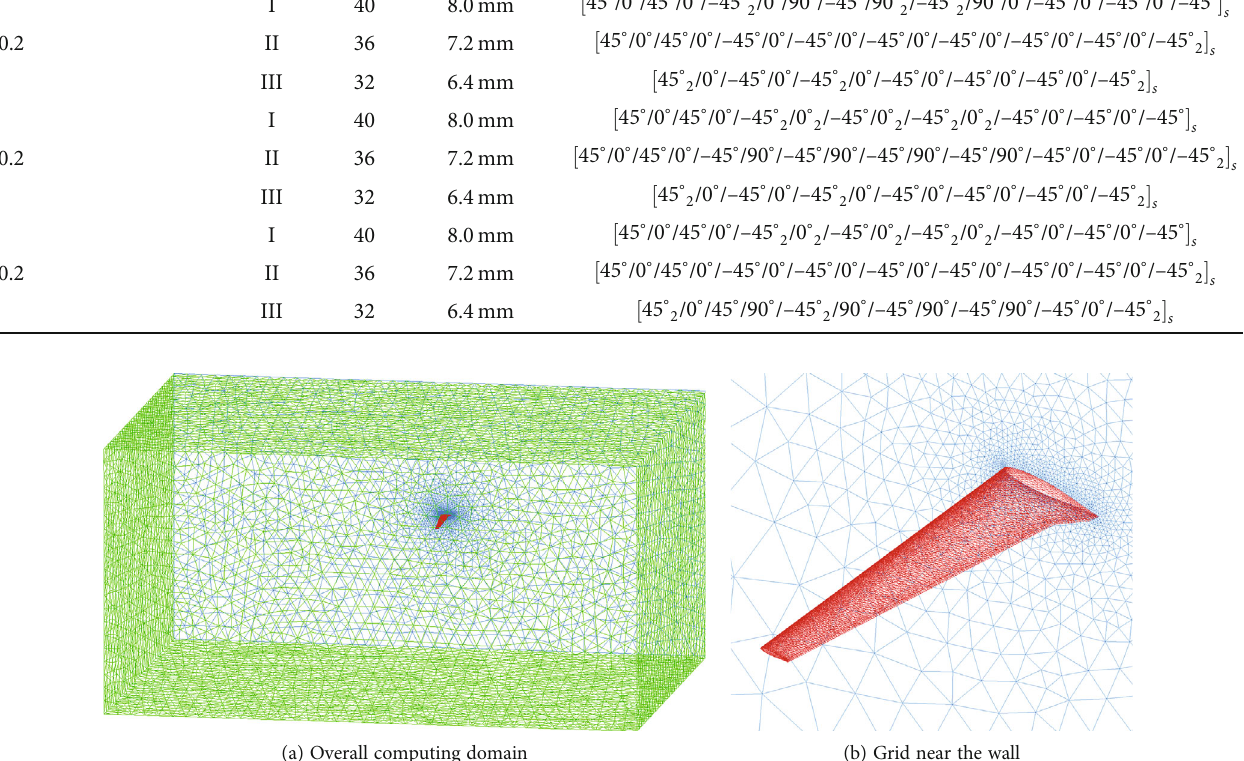
Figure 8: Calculation domain and mesh of fl ow fi